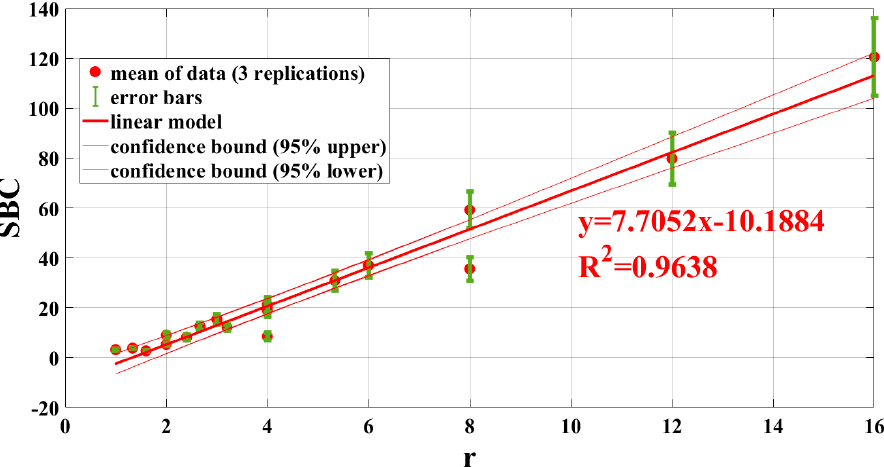
Figure 17. SBC versus r for PCT (2nd principal component) 1024 frames, error bands and confidence bounds on the find linear model.